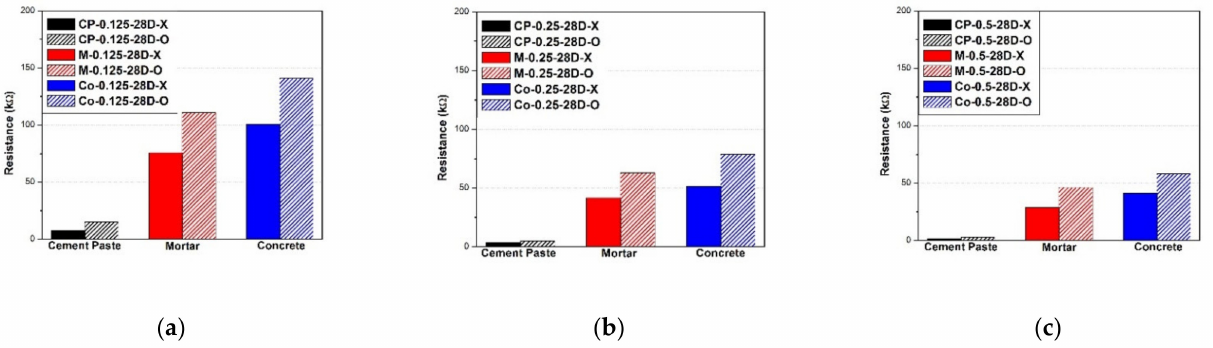
Figure 12. Electrical resistance at 28 curing days: ( a ) 0.125 wt%, ( b ) 0.25 wt%, and ( c ) 0.5